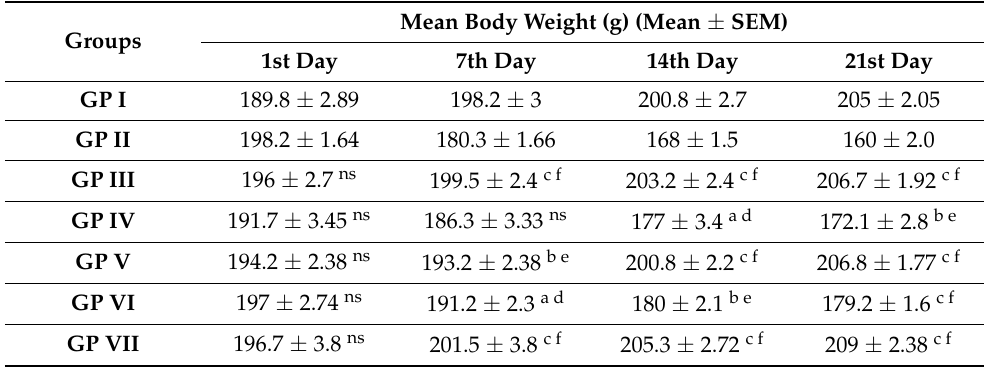
Table 2. Effect of PGE and PGAg NPs on body weight (g) in STZ-induced diabetic